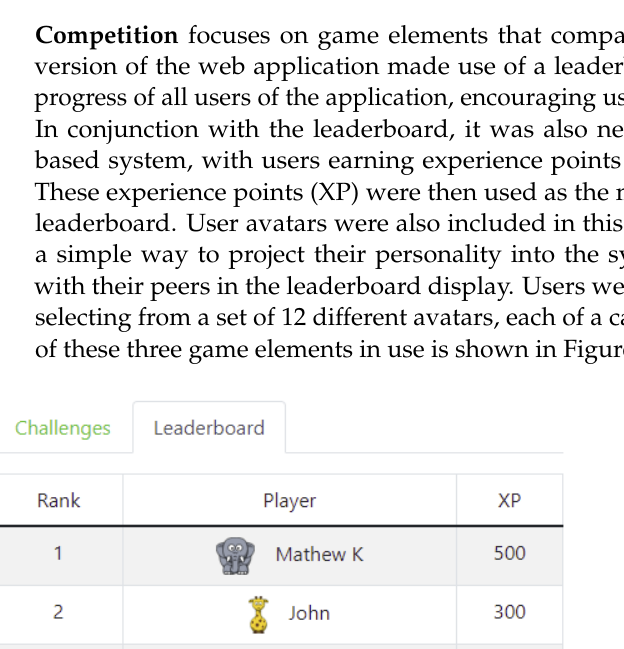
Figure 6. Example of a progress bar.